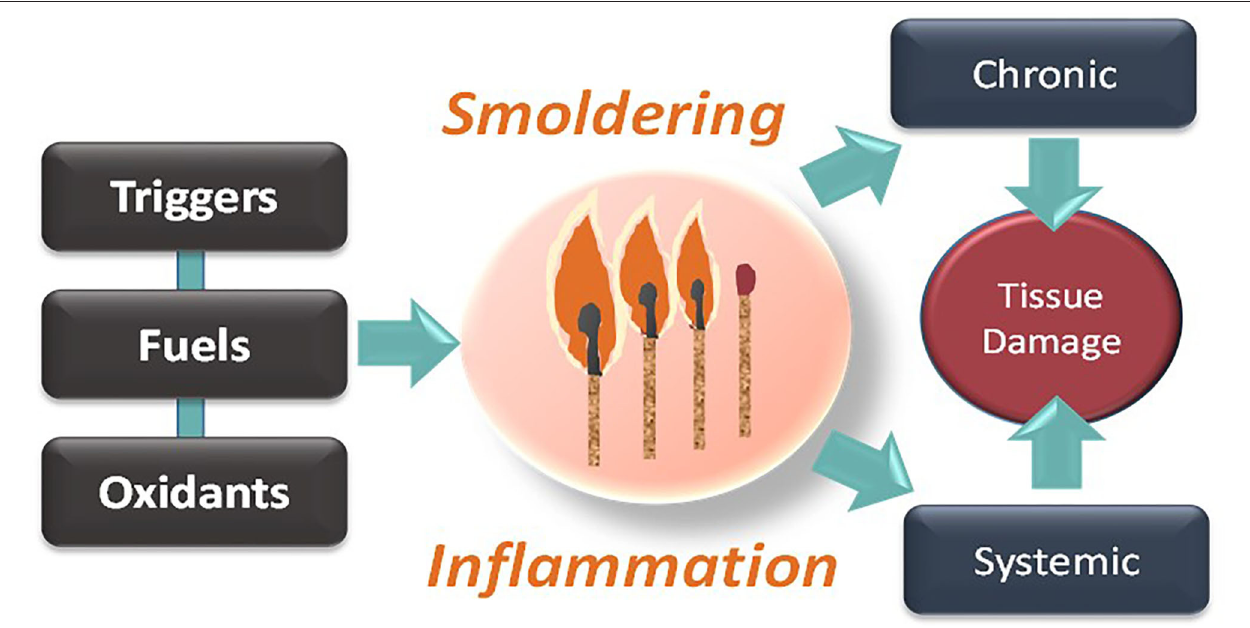
FIGURE 1 | Smoldering inflammation as a progressive disease requiring triggers, fuels, and pro-oxidative conditions, ultimately resulting in systemic tissue and chronic